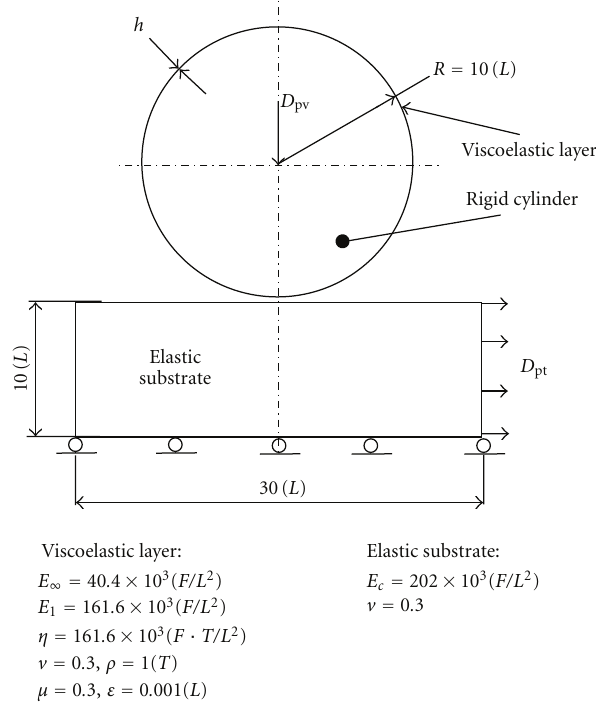
Figure 4: Contact of a layered rigid cylinder with an elastic